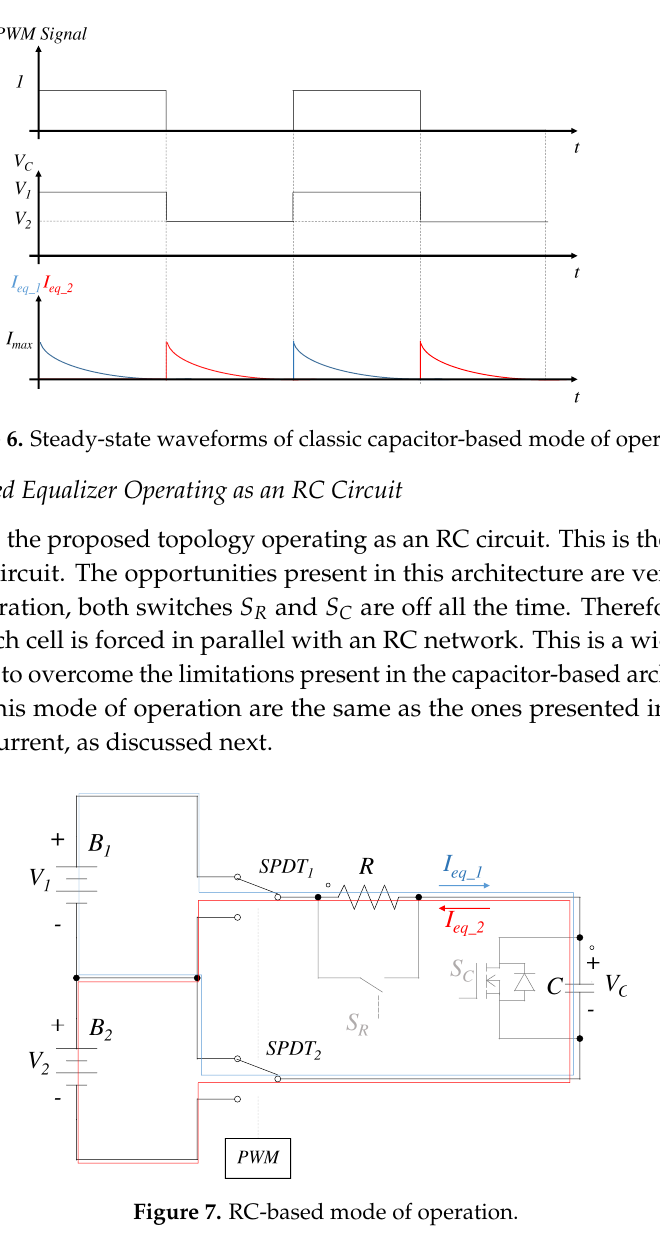
Figure 5. Capacitor-based mode of operation.